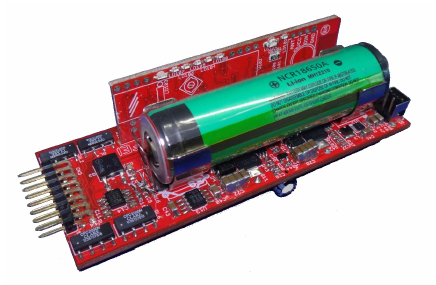
Figure 9. Hardware